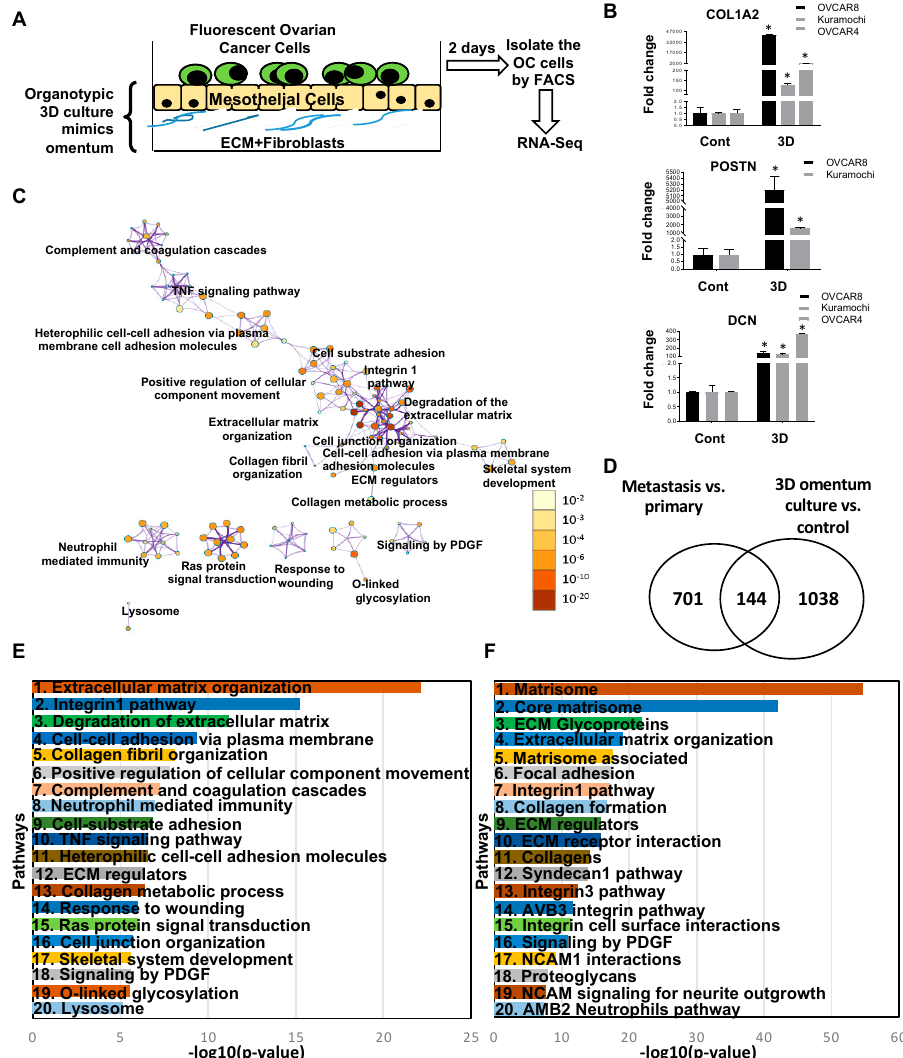
Figure 7. Early and advanced metastatic colonization. ( A ) Schematic of omental three-dimensional (3D) organotypic culture model. Normal omental fibroblasts were mixed with Collagen I, seeded in a culture dish and allowed to attach and polymerize, resembling the basement membrane of the omentum. Omental mesothelial cells were overlaid on it as a confluent monolayer to mimic the mesothelium and the culture was allowed to secrete extracellular matrices (ECMs) and factors for 24 h to form a complex microenvironment. Thereafter, green fluorescent protein (GFP)-labeled high-grade serous ovarian cancer (HGSOC) cells (Kuramochi / OVCAR4 / OVCAR8) were seeded on the 3D omentum culture, allowed to grow for 2 days and then isolated by fluorescence activated cell sorting and used for RNA-seq. Three independent experiments were done for each cell. ( B ) The top three di ff erentially expressed genes were validated by qRT-PCR all three cells. * p < 0.01, error bars indicate standard deviation for three replicates. ( C ) Network analysis of pathways deregulated in 3D culture versus cell culture where node color intensity corresponds to the gene enrichment for a particular pathway and the node size correlates with statistical significance. The interaction modules are clustered on the basis of functional similarities. ( D ) Venn diagram showing the common deregulated genes in all the 3 HGSOC cells on 3D omentum culture versus control and metastasis versus primary tumors. ( E ) Top 20 deregulated pathways in all the three HGSOC cells seeded on 3D omentum culture versus control plotted against − log 10 ( p -values). ( F ) Top 20 common deregulated pathways in all the 3 HGSOC cells seeded on 3D omentum culture versus control and metastasis versus primary tumors plotted against − log 10 ( p